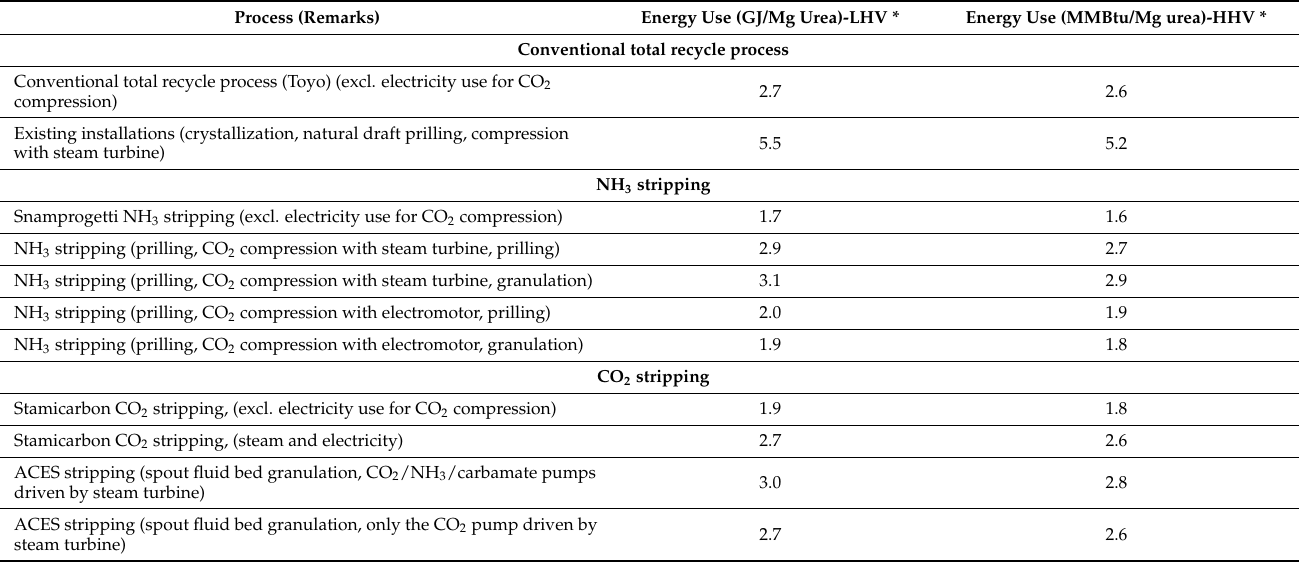
Table 1. The overall energy use for urea production in fertilizer plants [47] .